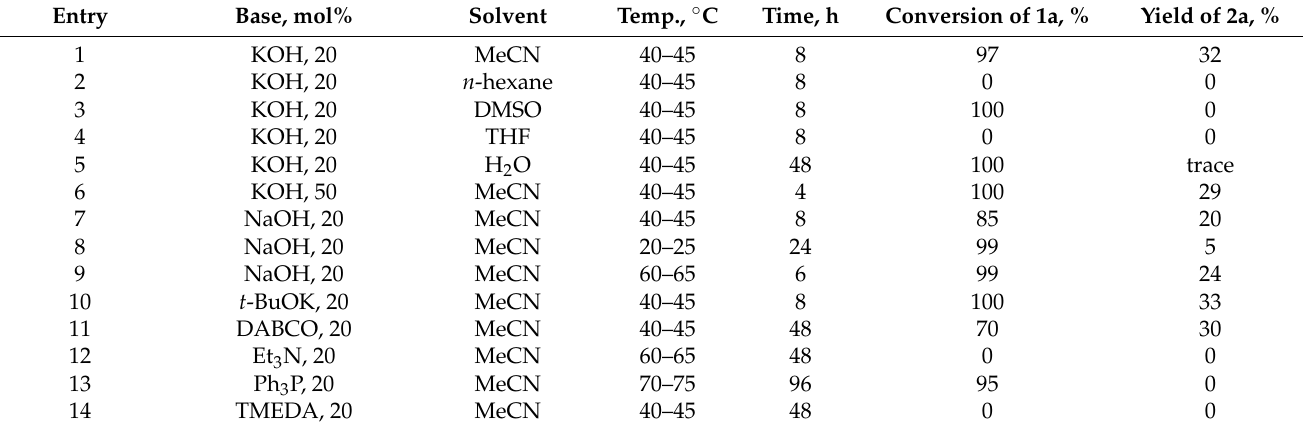
Table 2. Conditions for [3+3]-cyclodimerization of benzoylethynylpyrrole 1a under the action of bases.